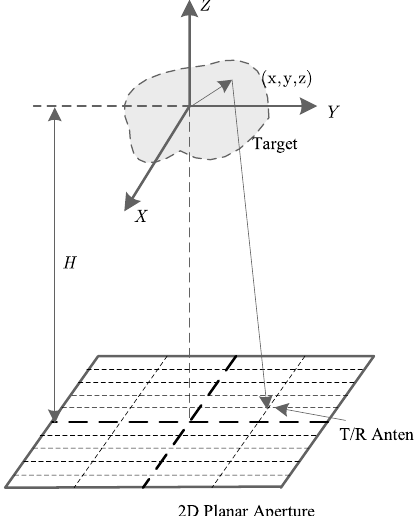
Fig. 9 Experimental principle of real data